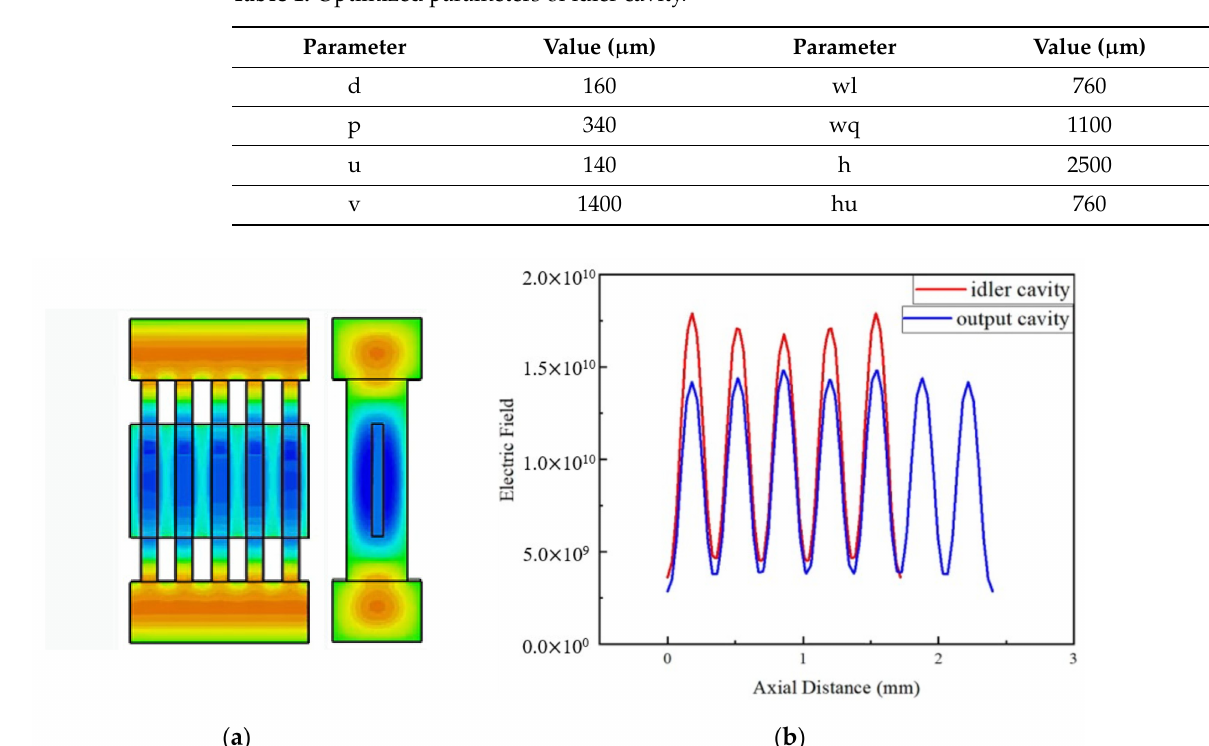
Figure 3. Electric field distribution for the 5-gap idler cavity and 7-gap output cavity. ( a ) Electric field distribution and mode pattern for 5-gap idler cavity. ( b ) Axial electric field distribution for idler and output